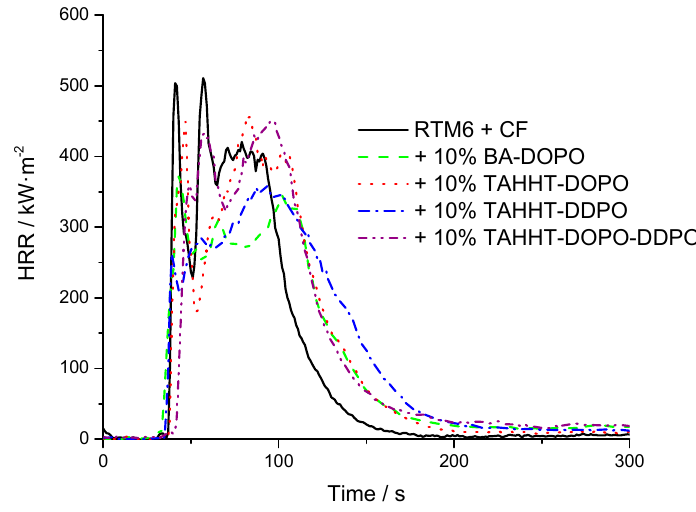
Figure 7. HRR of reinforced samples at 60 kW·m − 2 .